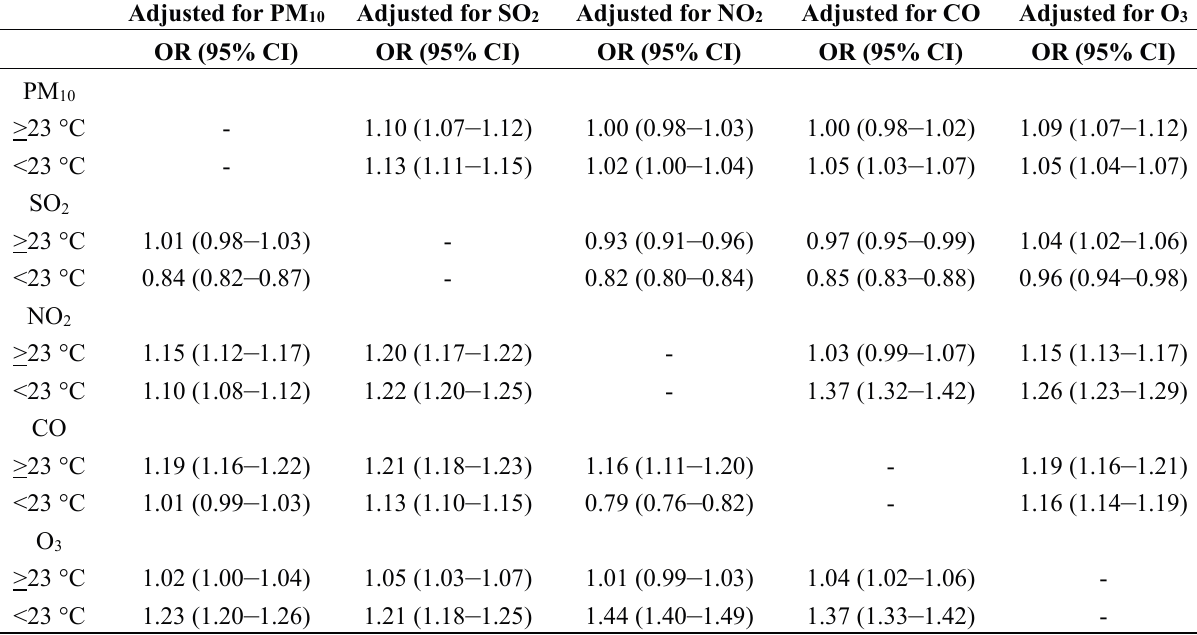
Table 4. Odds Ratio (OR) and 95% Confidence interval (CI) for daily migraine visits for each interquartile range increase † in single-pollutant model in Taipei, Taiwan, 2006–2011 § . Adjusted for PM 10 Adjusted for SO 2 Adjusted for NO 2 Adjusted for CO Adjusted for O